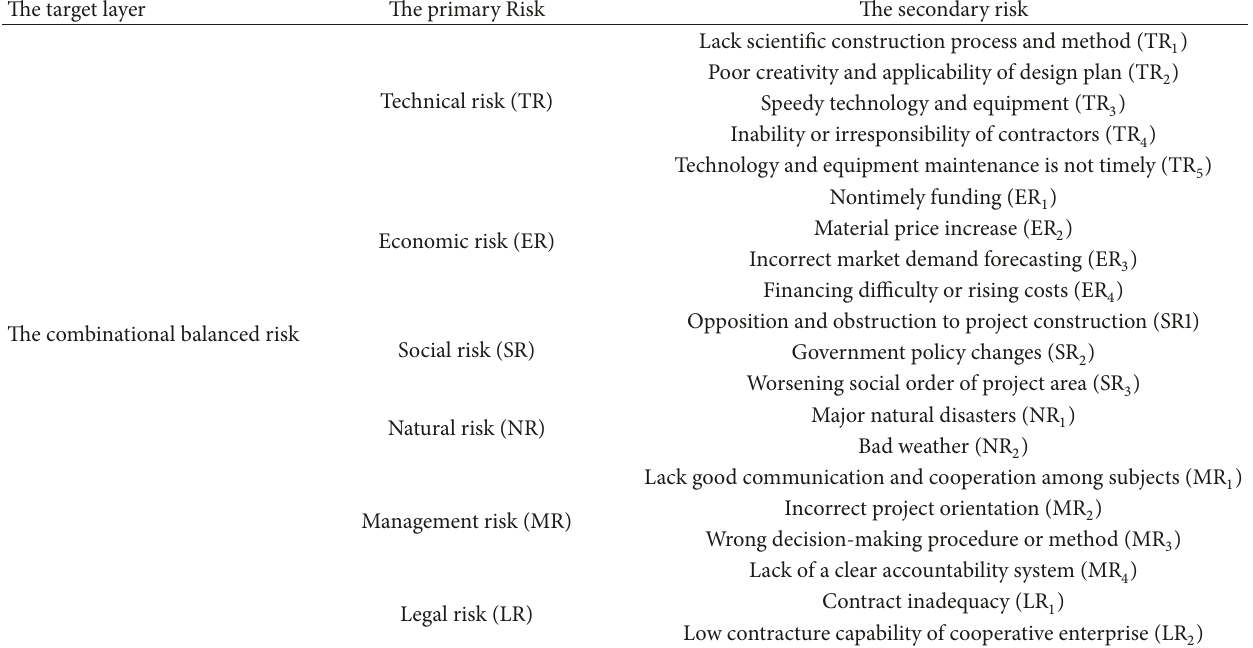
Table 4: Portfolio balanced risk index system of a major infrastructure